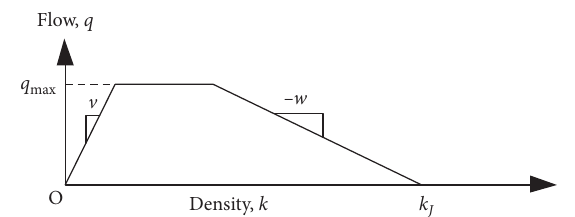
Figure 5: Flow-density relationship for the generalized CTM [40].